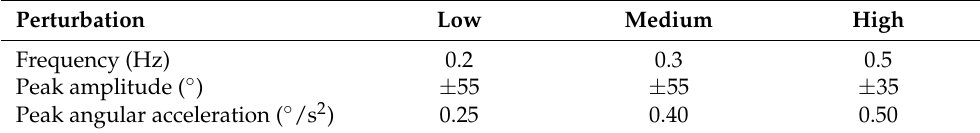
Table 2. Resume of tasks provided by the Rotobit 1D